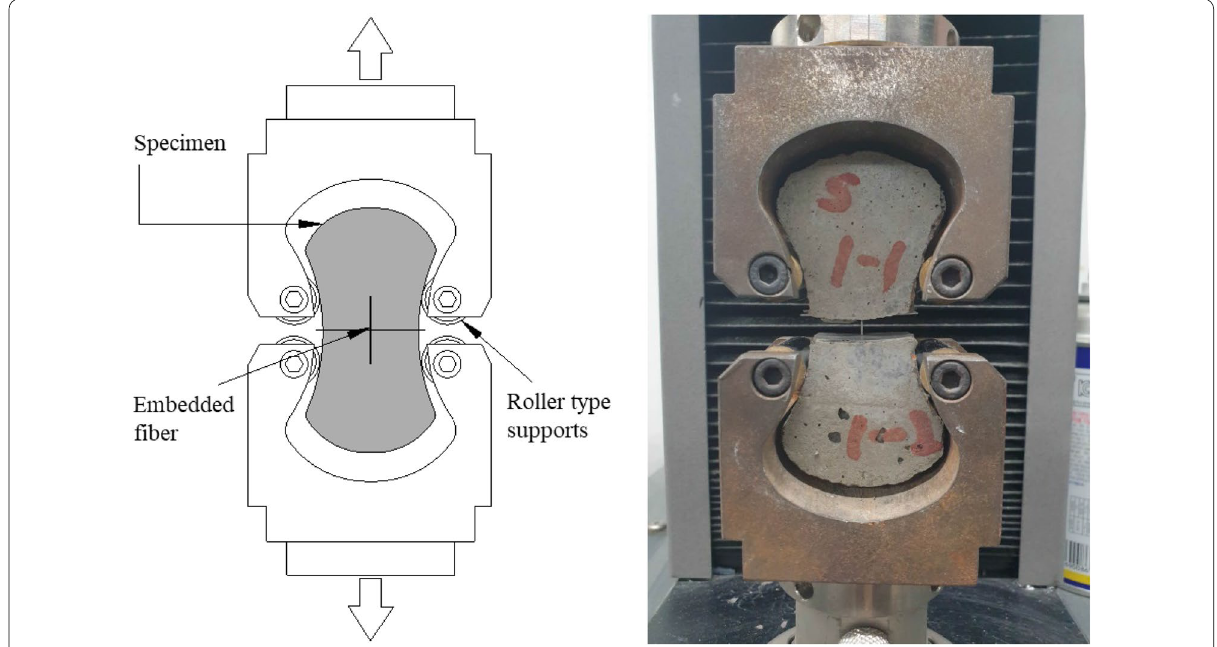
Fig. 3 Fiber pullout test